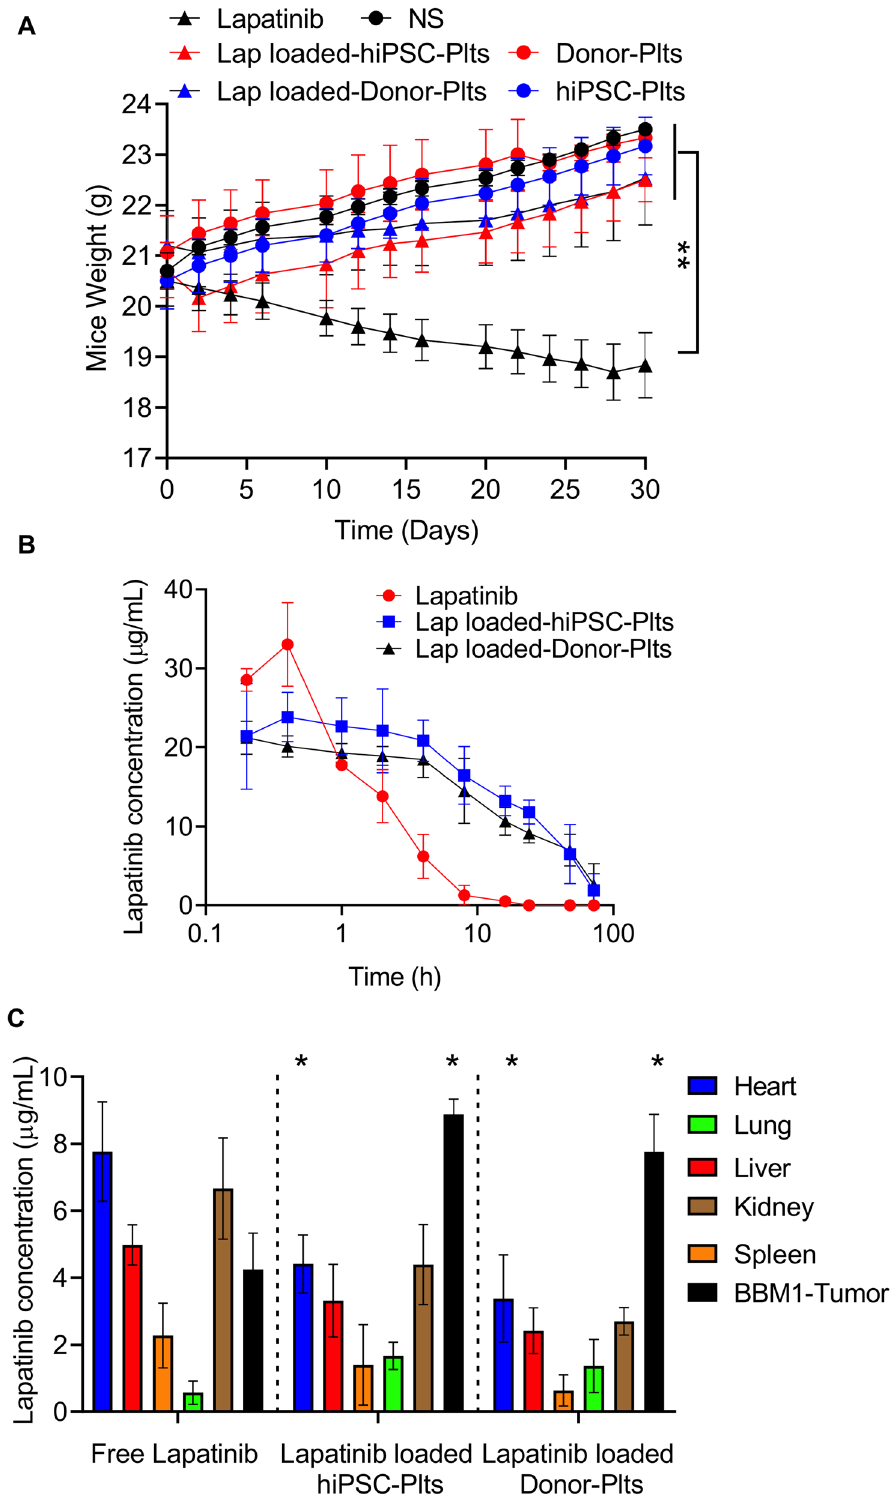
Figure 5. In vivo distribution of lapatinib-loaded hiPSC-platelets. (A) Body weights of variously treated BBM1- derived tumor-bearing female NOD/SCID mice (n = 7) over a 30-day period. ** indicates p < 0.001. (B) Plasma concentrations of lapatinib, measured by LC–MS/MS after injection with free lapatinib or lapatinib-loaded hiPSC- and donor-derived platelets in NOD/SCID mice (n = 7). Lapatinib-loaded hiPSC- and donor-derived platelets vs. free lapatinib, * p < 0.001. (C) Lapatinib concentrations in various tissues of female NOD/SCID mice (n = 7), collected 4 h after infusion with free lapatinib or lapatinib-loaded hiPSC- and donor-derived platelets. * indicates p <